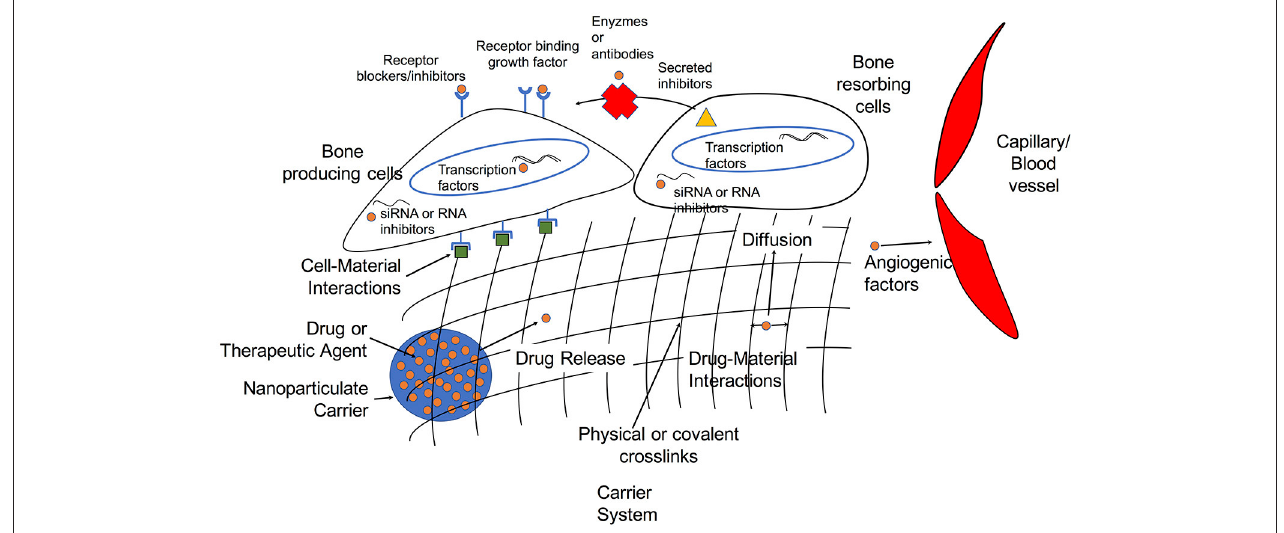
FIGURE 1 | Overview of targets and delivery strategies for growth factors and therapeutic agents in tissue engineering approaches to bone